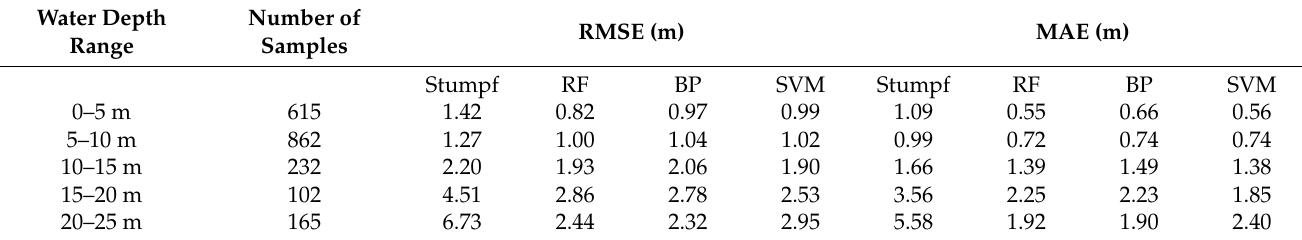
Table 4. Water depth range subsection